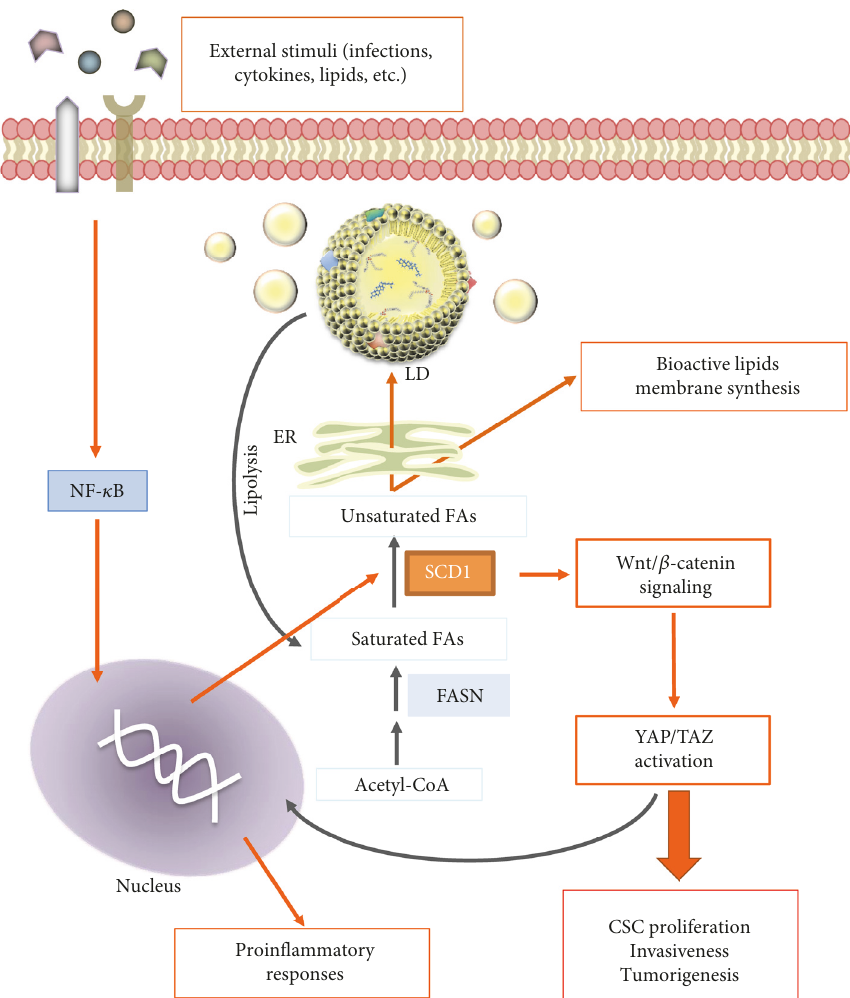
Figure 5: Hypothetical model of NF-kB/SCD1 pathway based on [177, 185]. Activated NF-kB pathway stimulates SCD1 upregulation, which could modulate several pathways (such as Wnt/ β -catenin and YAP/TAZ signalings) resulting in CSC proliferation, cancer invasiveness, and